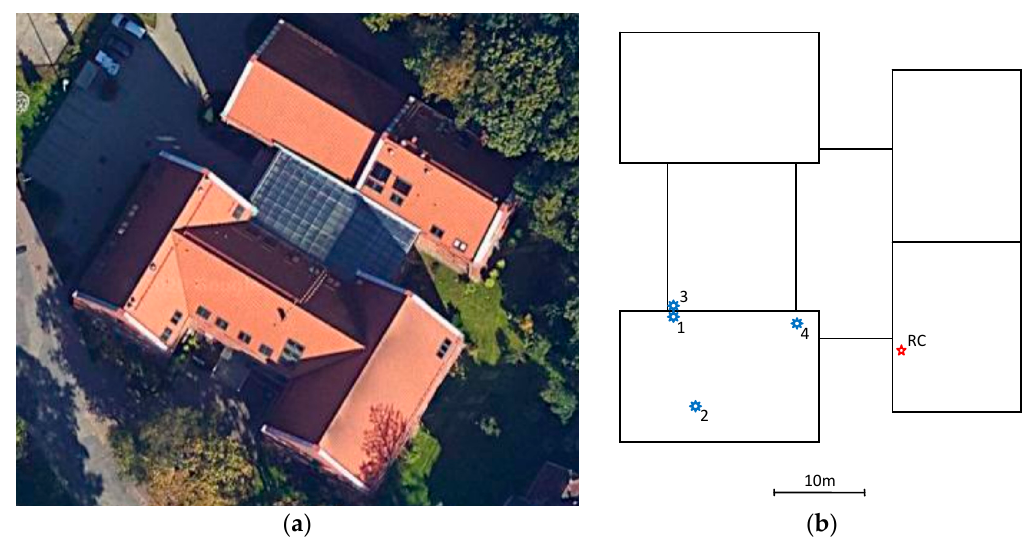
Figure 11. Monitored building: ( a ) General view [26] ( b ) Scheme of location of measurement nodes (RC—request center on the top floor, 1 , 2 , 3 , 4